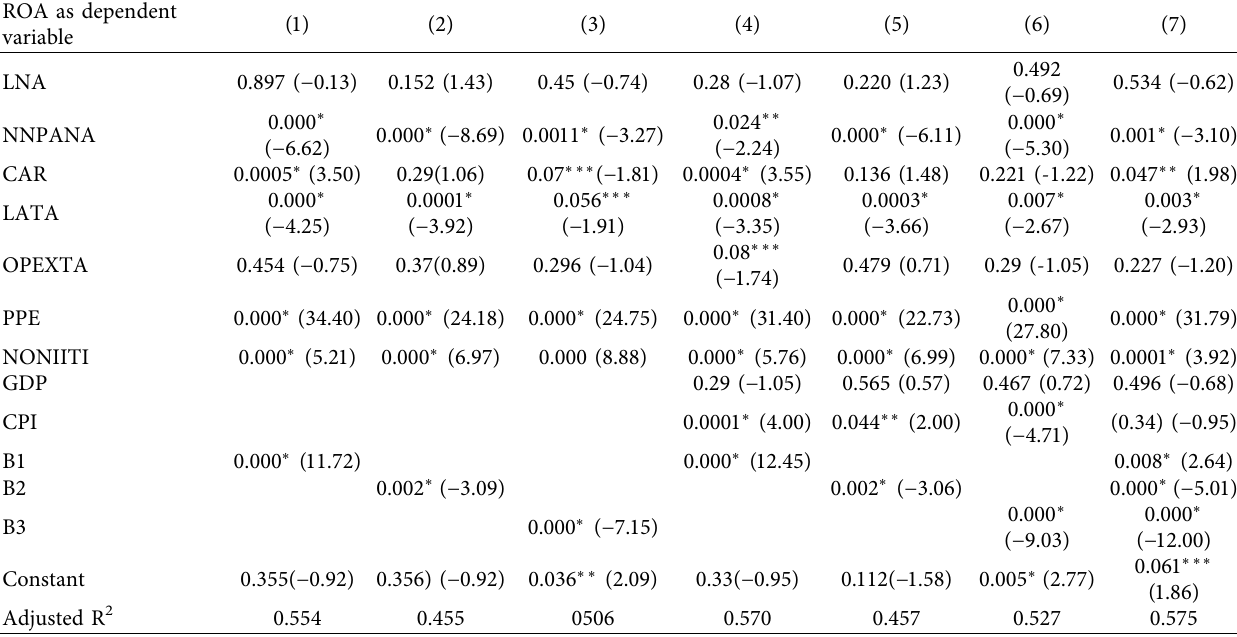
Table 5: Robust regression analysis with return on